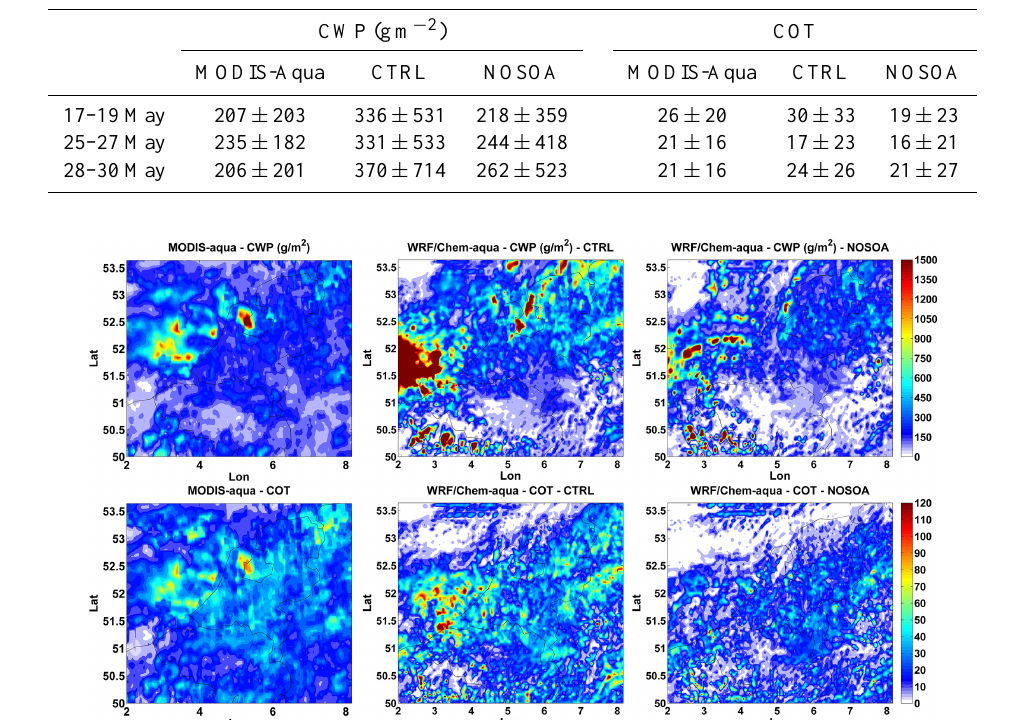
Table 5. MODIS and modelled mean values and standard deviations of cloud water path and cloud optical thickness of clouds in all phases,